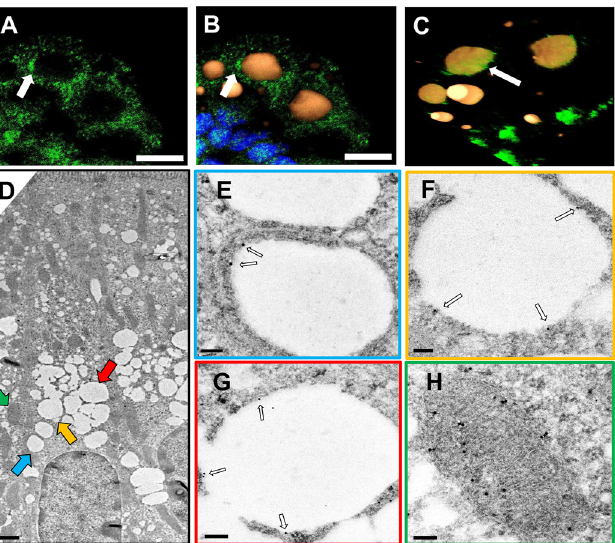
Fig 6. Immunofluoresence and immunoelectron imaging of Acsl5 demonstrates localization on or around CLDs. Representative confocal immunofluorescence images (n = 4 mice) and immunoelectron micrographs (n = 2 mice) of enterocytes two hours after a 200 μ l olive oil bolus. Frozen sections were immunostained for Acsl5 (A). Lipids were stained with Bodipy (orange), nuclei stained with Dapi (blue), and the signals were merged. Bars = 5 μ m (B). A 3D volume view was generated from Z-series images with the dimensions of 21.21 x 21.21 x 3.25 μ m and indicates Acsl5 localizes to the area on or around the CLD (C). An immunoelectron micrograph of an enterocyte containing CLDs two hours post a 200 μ l olive oil bolus with areas of interest highlighted by colored arrows. Scale bar = 1 μ m. Colored arrows correspond with colored boxes of images E-H (D). CLDs are labeled with nanogold conjugated anti-Acsl5 antibody as indicated by the white arrows. Bars = 100 nm (E-G). Additionally, Acsl5 gold labeling was also observed in mitochondria. Bars = 100 nm